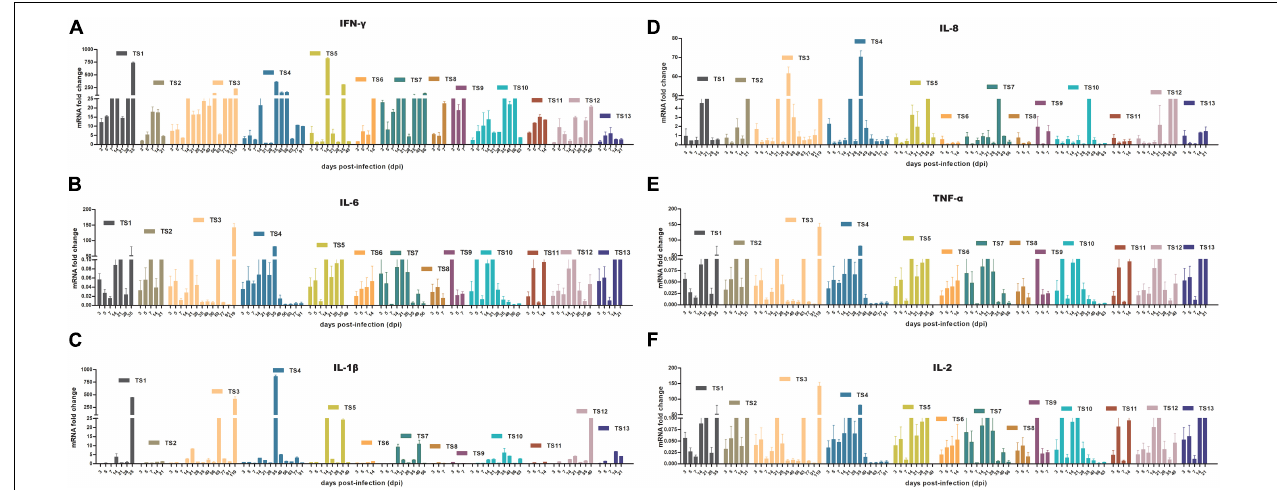
FIGURE 8 | KSHV induces an innate antiviral response in TS1–13 tree shrews in vivo . (A) IFN- γ . (B) IL-6. (C) IL-1 β . (D) IL-8. (E) TNF- α . (F)